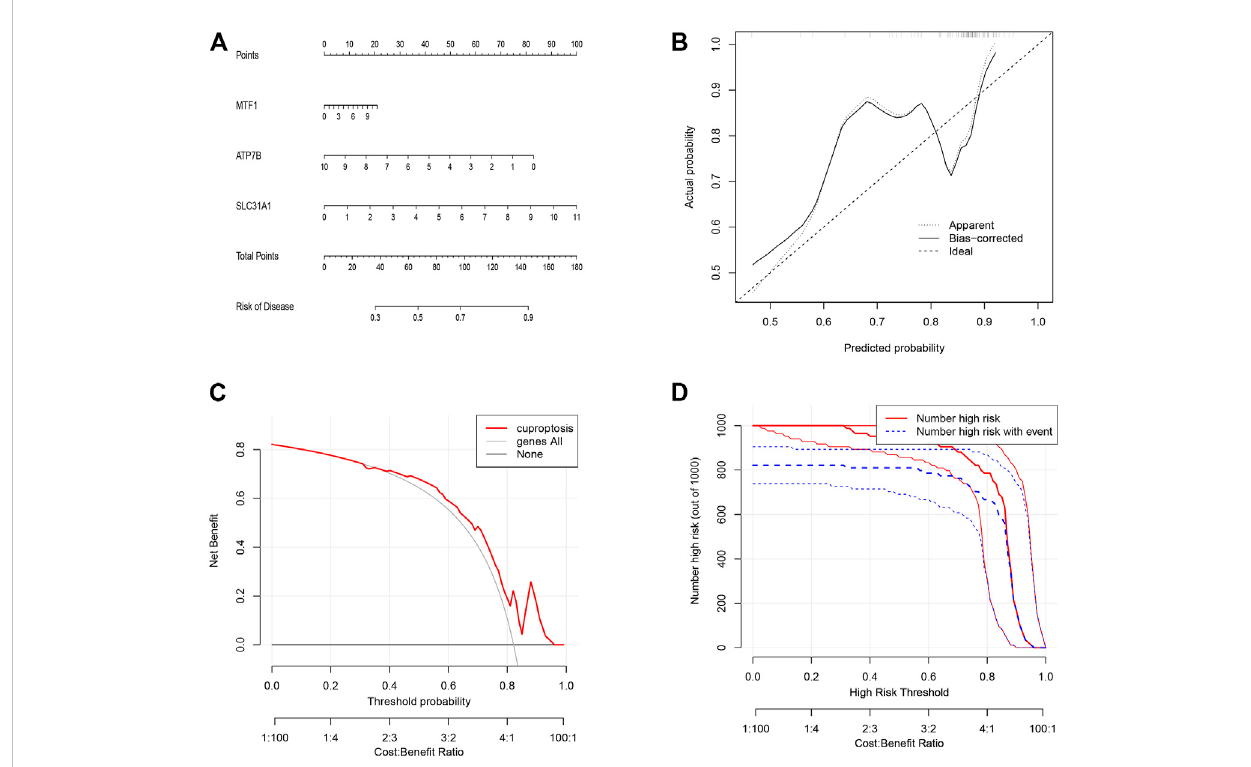
FIGURE 4 The construction of the nomogram model for cuproptosis regulators in psoriasis. (A) Construction of the nomogram model based on the three candidate cuproptosis regulators. (B) The calibration curve shows that the predictions of the nomogram model are accurate. (C) Nomogram-based decision-making may bene fi t psoriasis patients. (D) Assessing the clinical impact of the nomogram model by clinical impact